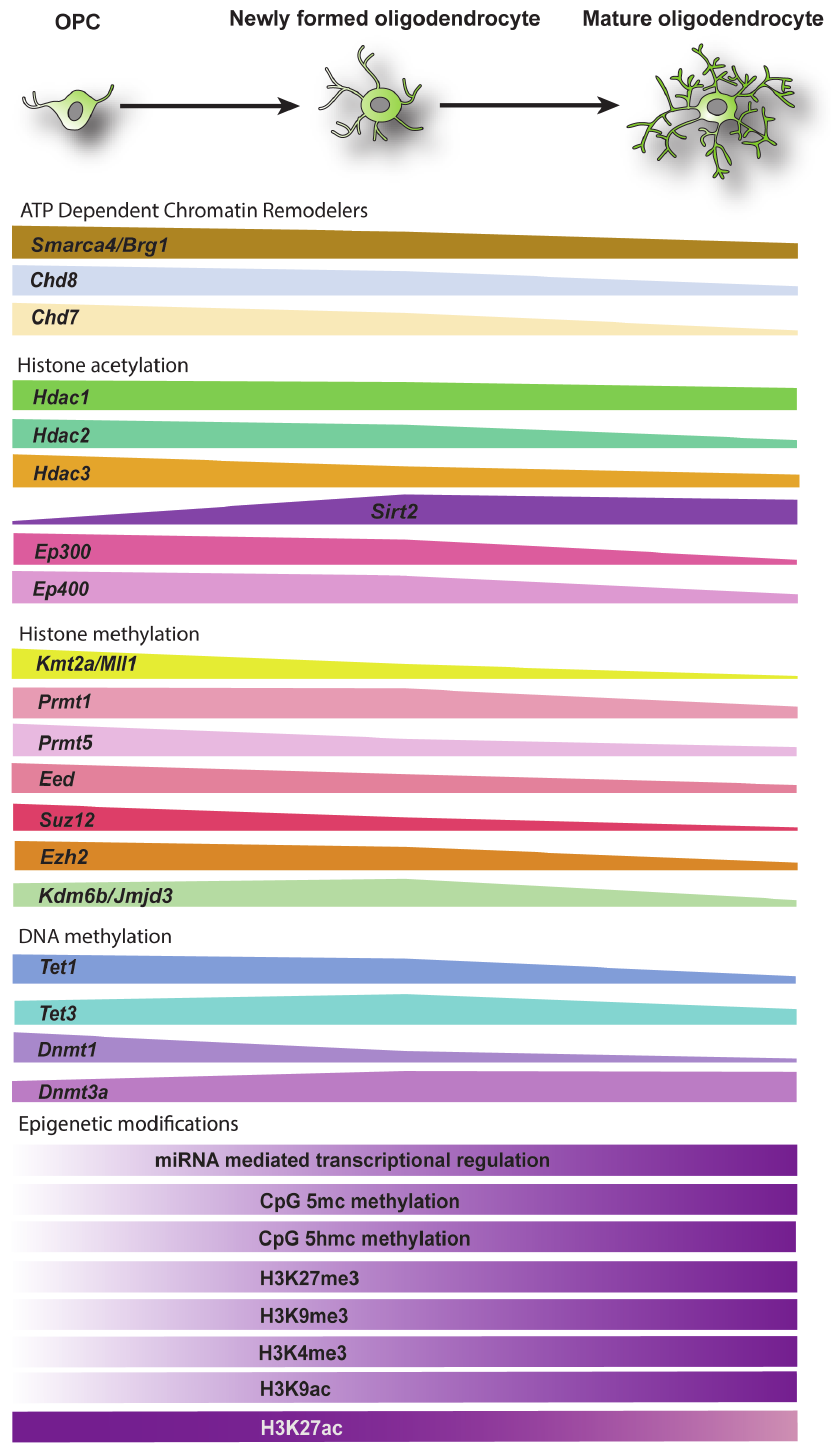
Figure 2. Global expression levels of key epigenetic regulators during oligodendrocyte differentiation from progenitor cells. Epigenetic modifiers, including ATP-dependent chromatin remodelers, histone acetyltransferases and deacetylases, histone methyltransferases, and demethylases, are critical components of the differentiation process, according to the data from a bulk RNA sequencing dataset 92 . The change of epigenetic modifiers across oligodendrocyte differentiation is depicted. The global changes of expression levels in the epigenetic modifications themselves are based on the studies 41,44,62,63,66,93 . OPC, oligodendrocyte progenitor